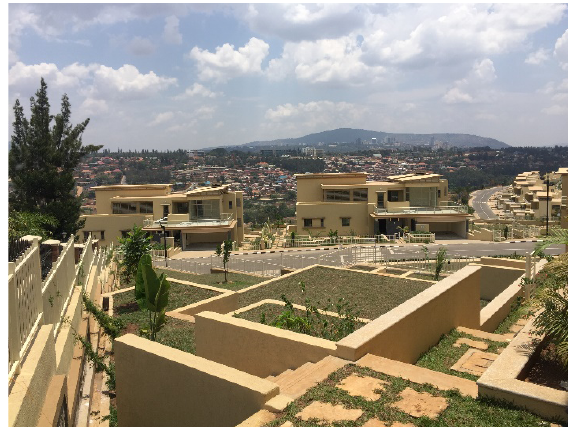
Figure 50. The Umudugudu Kigali Vision: 5-bedrooms Villa, front yard. Photograph by Manlio Michieletto.